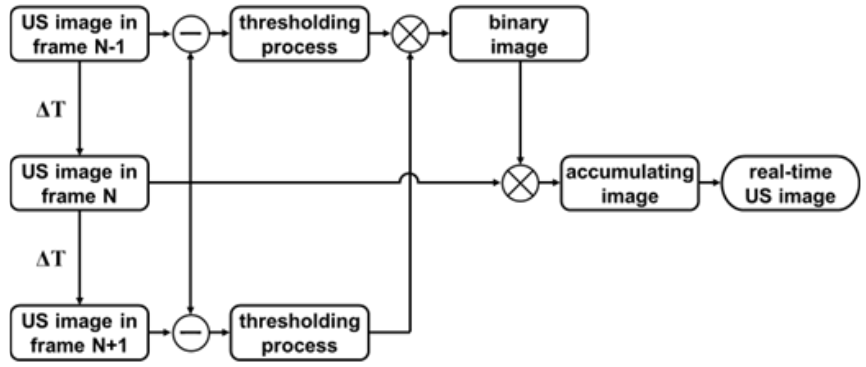
Figure 2. Flow chart of the three-difference algorithm for generating real-time US image.